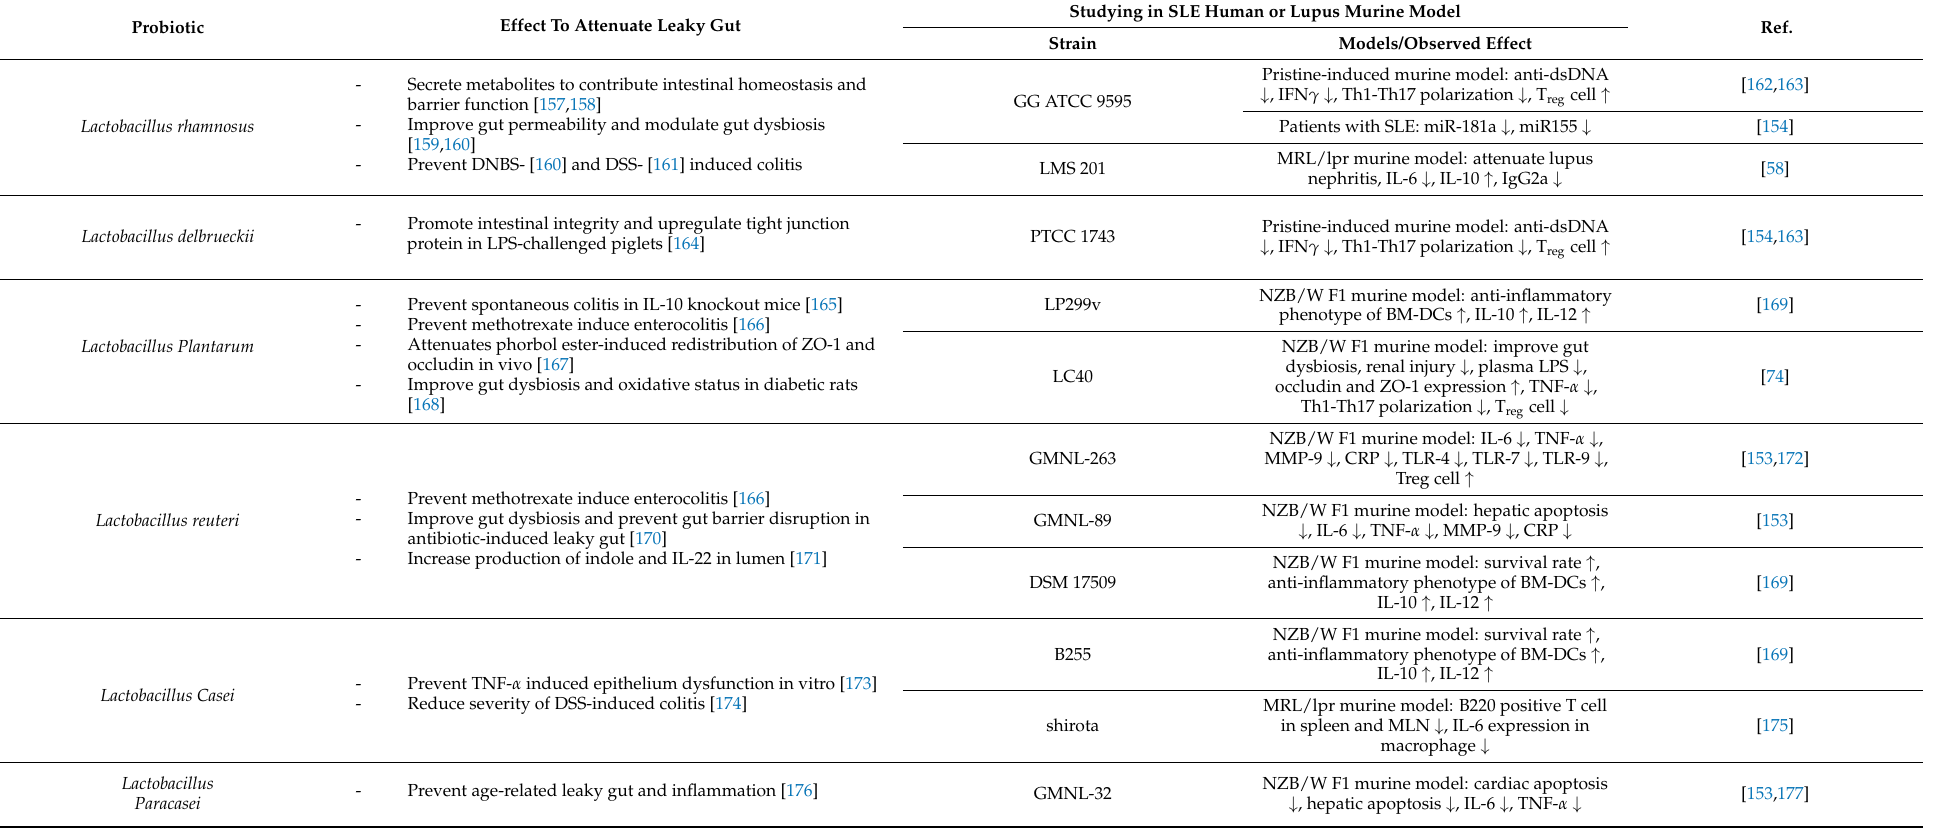
Table 1. Beneficial probiotics in